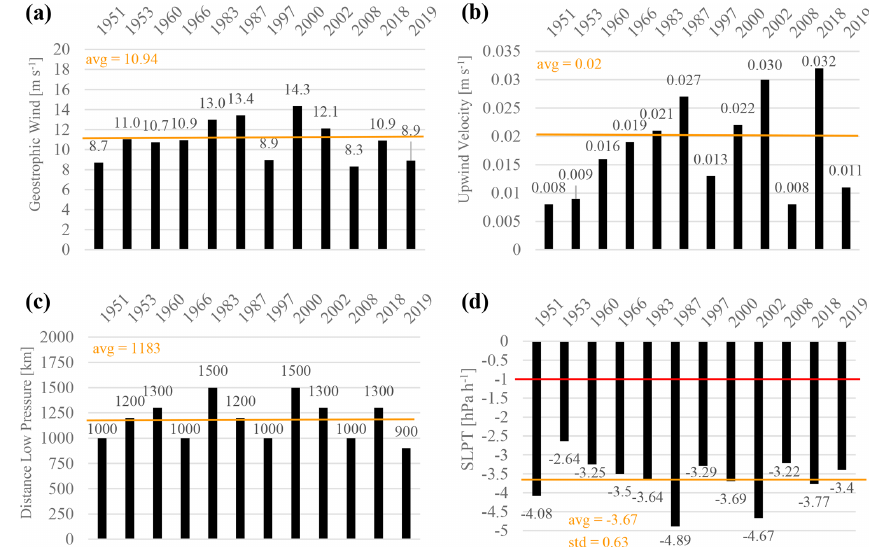
Figure 9. (a) Upwind velocity and (b) geostrophic wind velocity calculated for the T 1 term and (c) (cid:49)s 2 considered for the T 2 and T 3 terms. (d) The sea level pressure tendency (SLPT) index for the event analysed is computed. Orange lines represent the averages across the dataset while the red line indicates the threshold of explosive cyclogenesis (1hPah − 1 ).